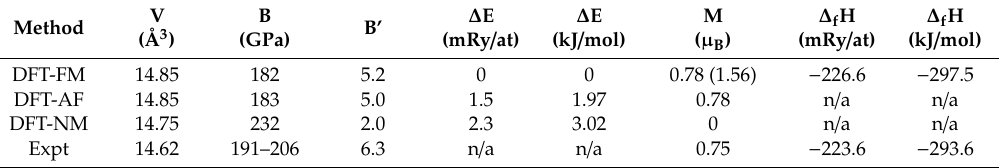
Table 1. Uranium mononitride (UN) results from density-functional-theory (DFT) ferromagnetic (FM), anti-ferromagnetic (AF), non-magnetic (NM) calculations and experimental data [3,20,21]. V, B, and B’ are the atomic volume, bulk modulus, and the bulk modulus pressure derivative (B’ = dB / dP), respectively. ∆ E is the relative total energy and M the total (spin and orbital) magnetic moment on the uranium atom. All results are obtained from calculations that include orbital polarization except for the magnetic moment in parenthesis that refers to a treatment with spin-orbit coupling only. ∆ f H is the formation enthalpy.